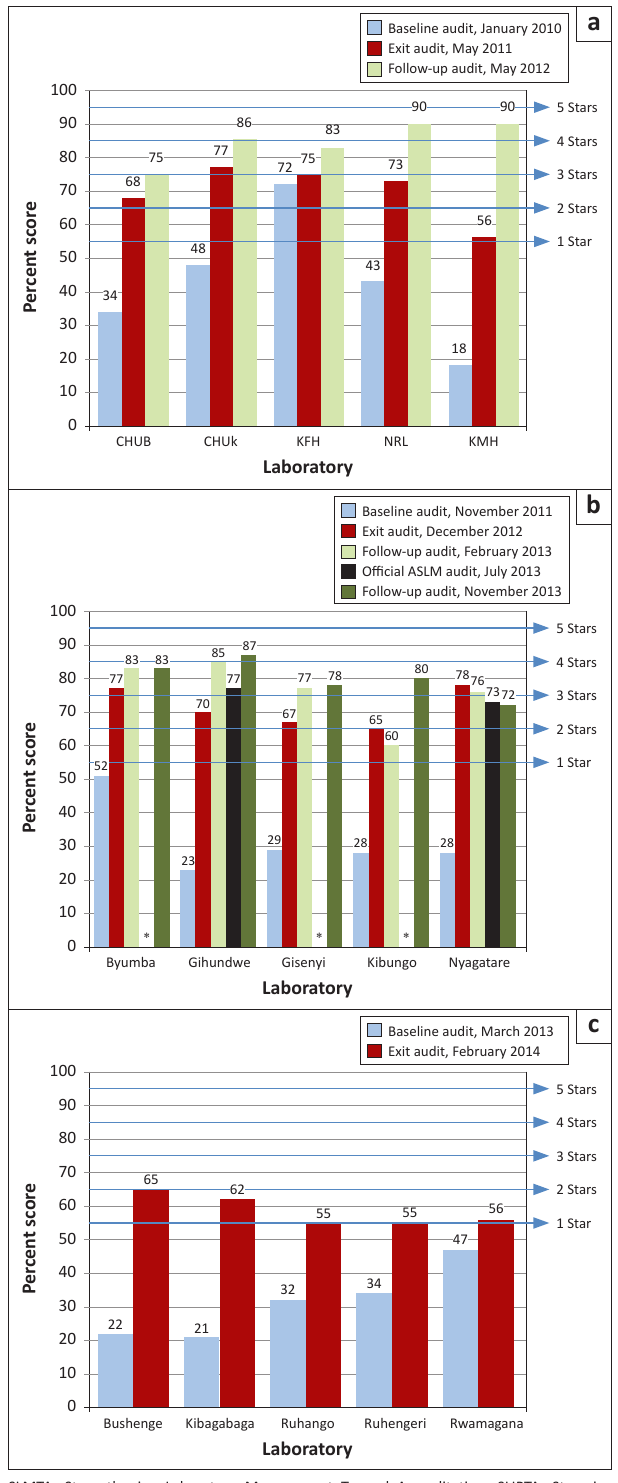
FIGURE 1: Progress of SLMTA Cohorts I (a), II (b) and III (c) in Rwanda based on SLIPTA checklist